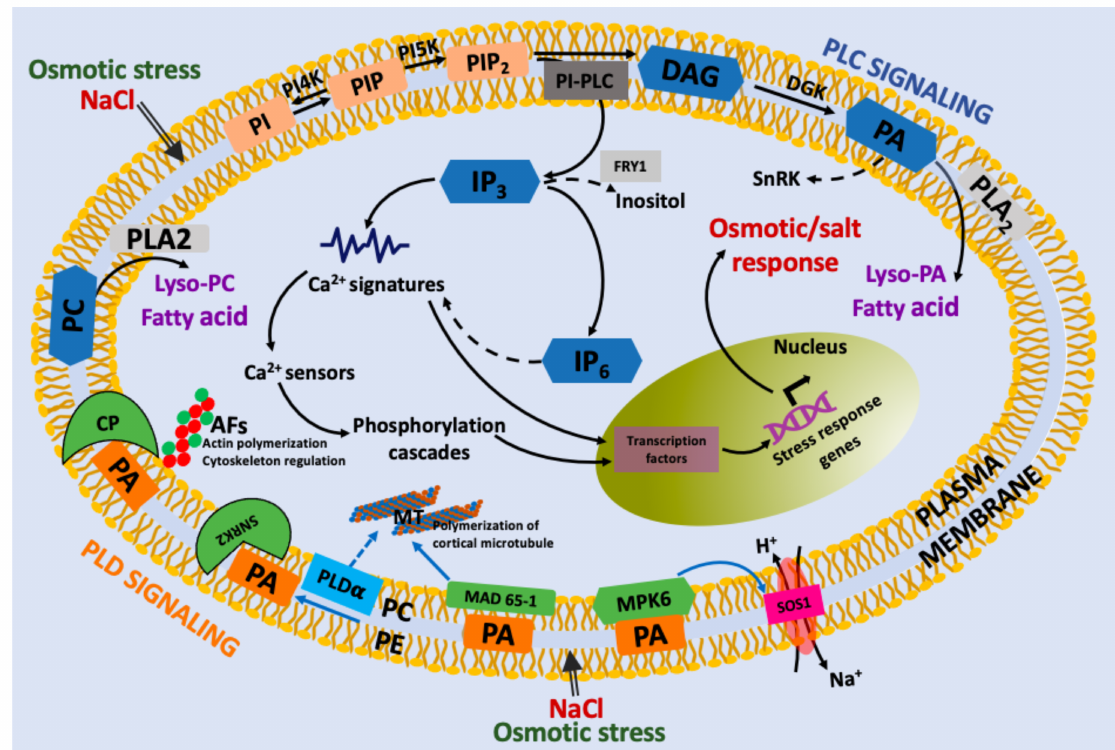
Figure 3. Proposed model for lipid-derived second messengers under osmotic and salt stress in plant cells. Osmotic and salt stress is perceived at the cell membrane, which activates PI-PLC, PLD and sphingolipid signaling to produce lipid second messengers that trigger the release of calcium from different sources, directly or indirectly. The changes in calcium concentration are sensed by calcium sensor proteins (e.g., CaM calmodulin, CML calmodulin-like protein sensors). In this response, PI-PLC and PLD signaling promotes a chain of reactions that includes IP 3 , IP 6 , and PA. PA has numerous targets, such as SNRK2 (snf1-related protein kinase2), MAD 65-1 (microtubule-associated protein MAD 65-1), and